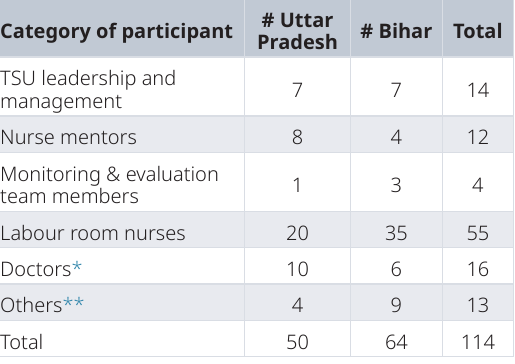
Table 2. Summary of interview participants.